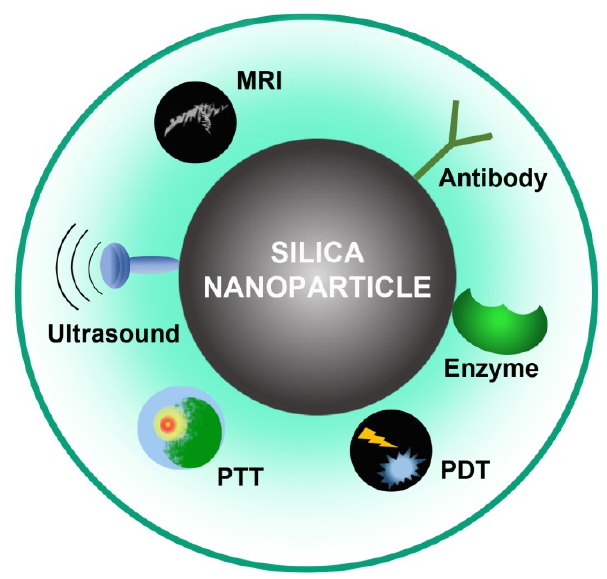
Figure 3. Biomedical applications of